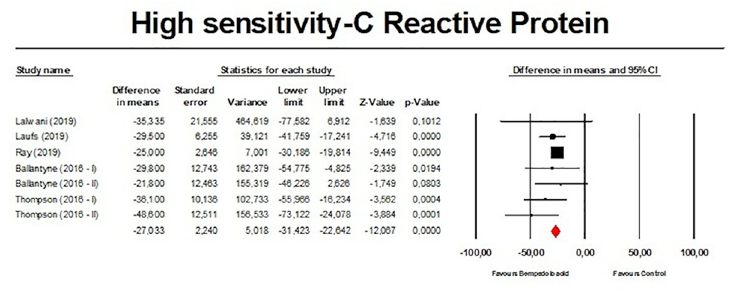
Fig 8. Forest plot displaying mean difference and 95% confidence intervals for the effect of bempedoic acid on plasma levels of high-sensitivity C-reactive protein.